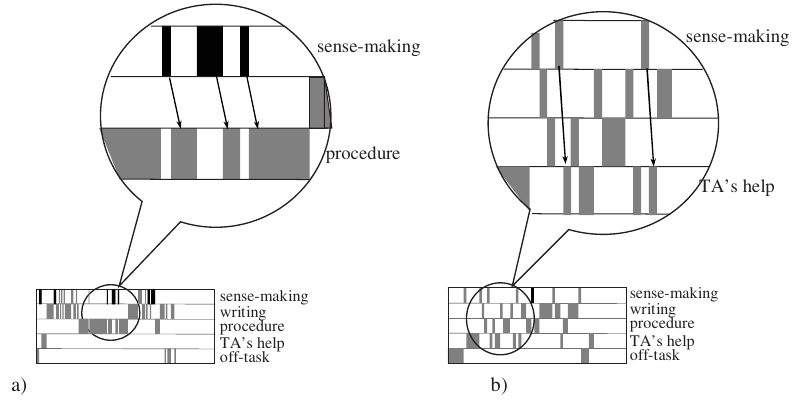
FIG. 4. Sense-making outcomes: (cid:1) a (cid:2) in ISLE labs a discussion leads to a de- cision and to an execution; (cid:1) b (cid:2) in non- design labs sense-making leads to a TA’s help, with the TA answering